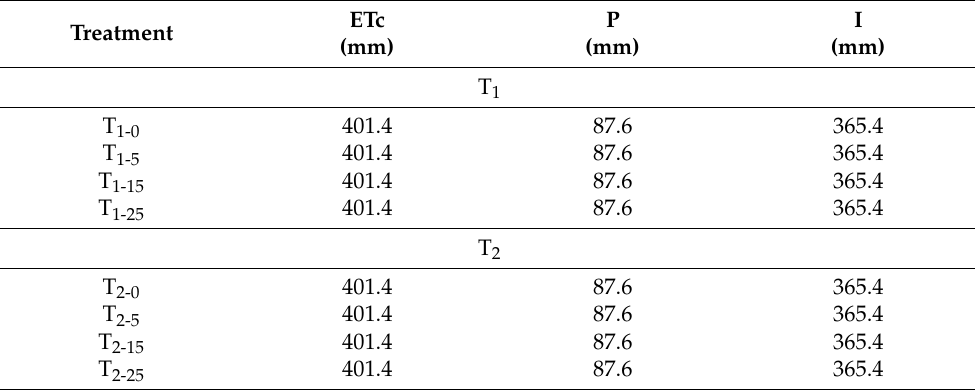
Table 4. Total applied water and crop evapotranspiration (mm).